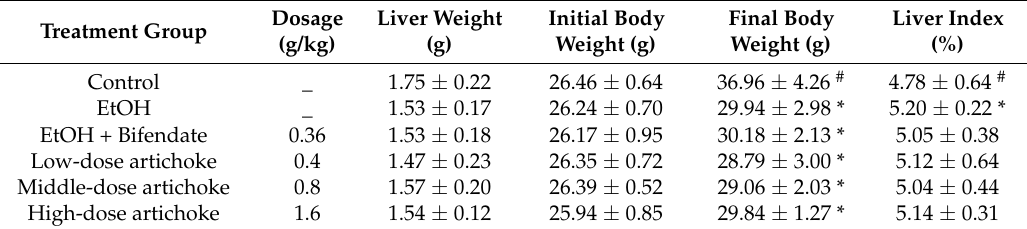
Table 1. Effect of artichoke on liver index of acute alcoholic liver disease (ALD) mice a . Treatment Group